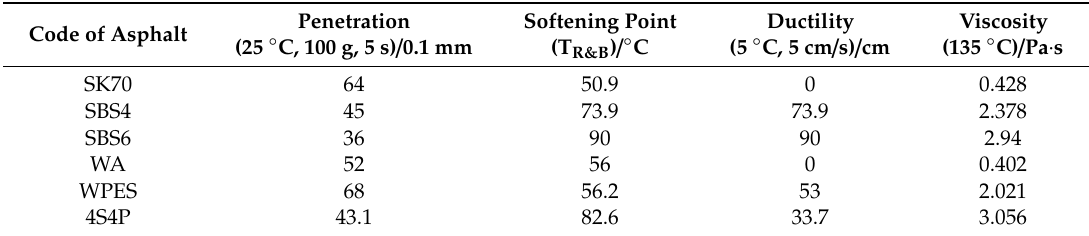
Table 2. Asphalts of the test and their properties.